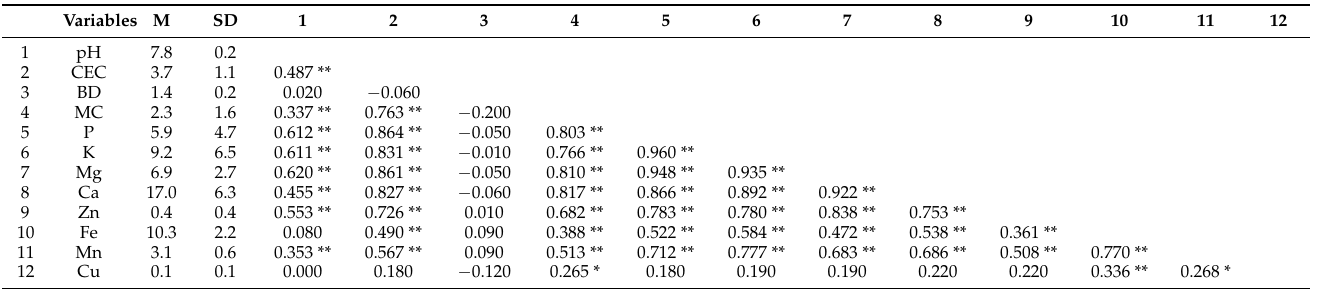
Table 4. Correlation coefficients between soil properties and available plant nutrients concentration in the